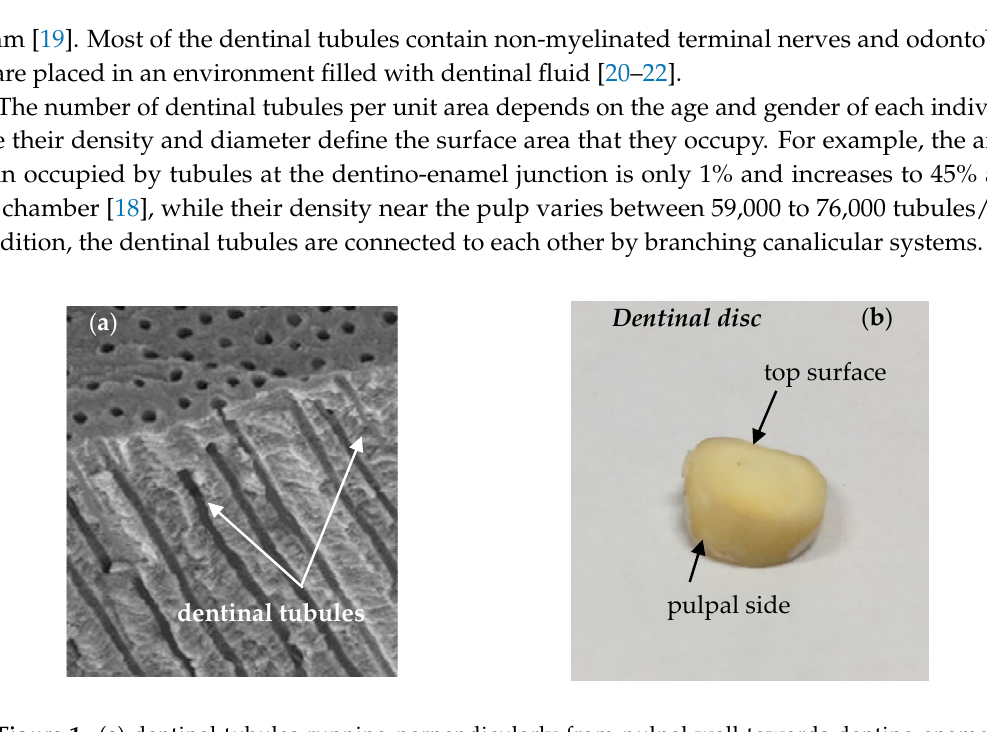
Figure 1. ( a ) dentinal tubules running perpendicularly from pulpal wall towards dentino-enamel junction ( DEJ) scanning electron microscopy (SEM), reproduced with permission from [17] and ( b ) dentinal disc of a human tooth.